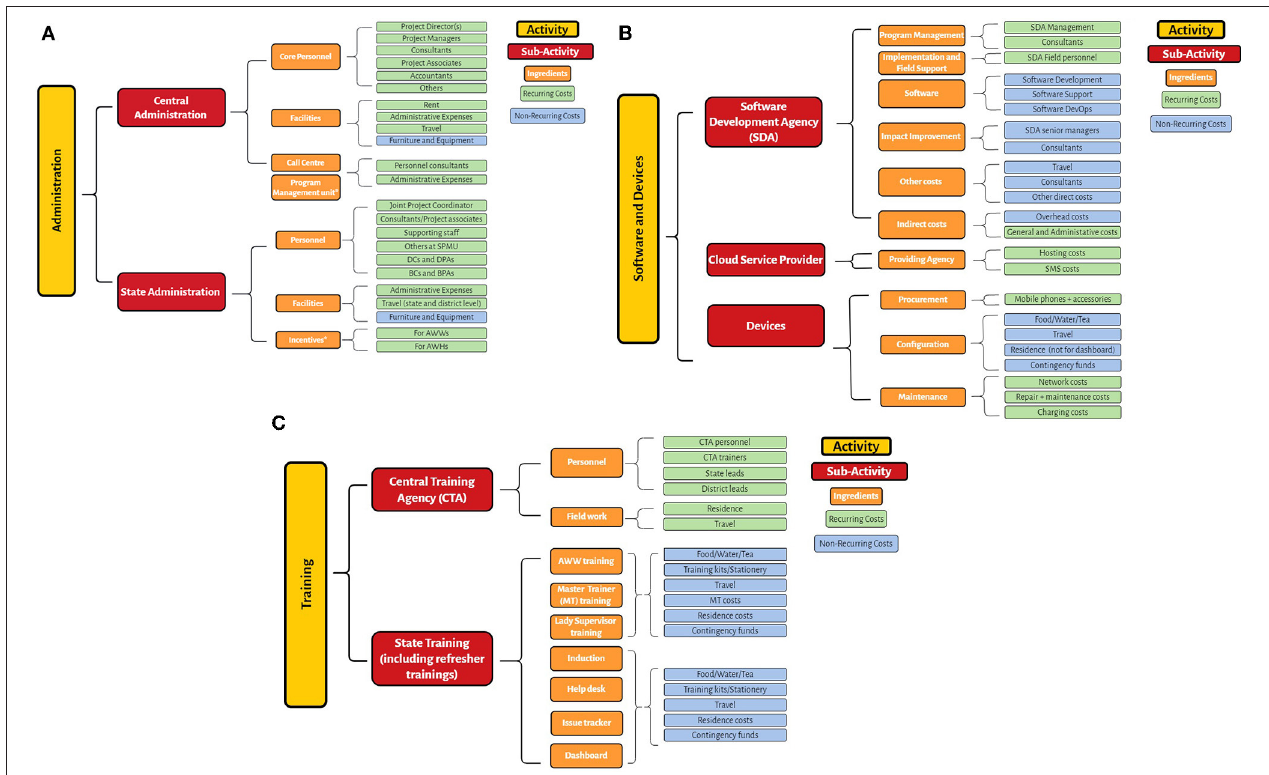
FIGURE 1 | (A) Activities and ingredients for ICDS-CAS: Administration. (B) Activities and ingredients for ICDS-CAS: Software and Devices. (C) Activities and ingredients for ICDS-CAS: